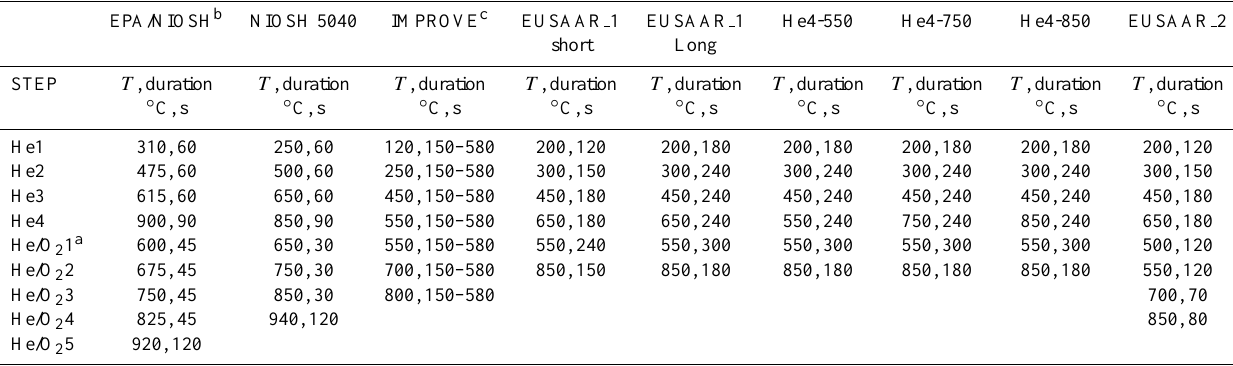
Table 1. Temperature protocols used to analyse samples in the present work: temperature set point and residence time are reported. EU- SAAR 2 protocol temperature set points and residence times are also